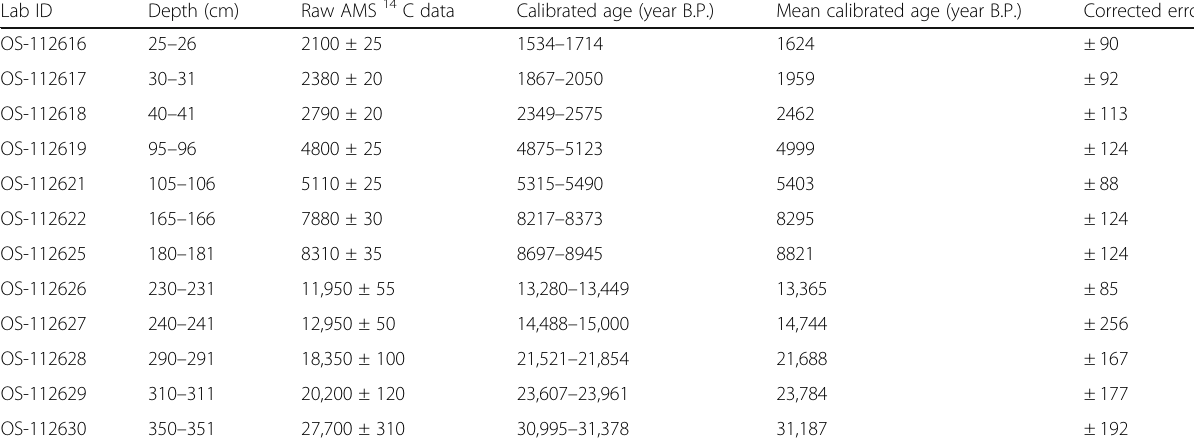
Table 1 AMS 14 C dating of SO184-10043 determined from planktonic foraminifer Globigerinoides ruber shells, and the 14 C ages were converted to calendar age by using CALIB7.1 (Reimer et al. 2013) Lab ID Depth (cm) Raw AMS 14 C data Calibrated age (year